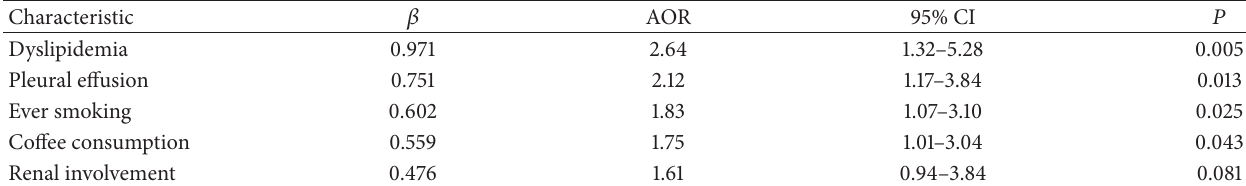
Table 4: Factors associated with CVD in patients with SLE ∗ .